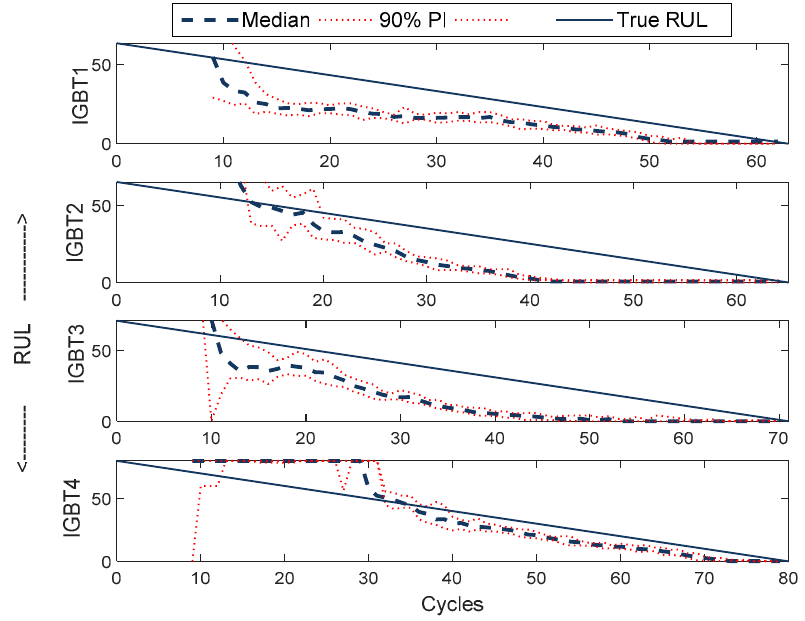
Figure 11. True and predicted RUL within the prediction interval.